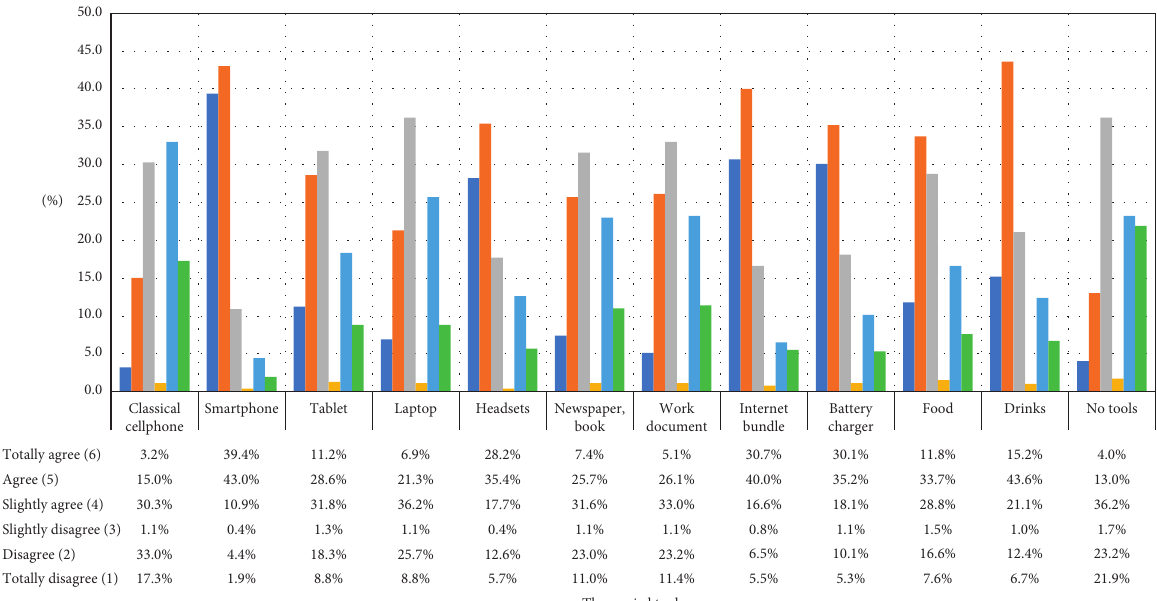
Figure 2: The participants’ responses concerning the positive impact of each carried tool on trip time.